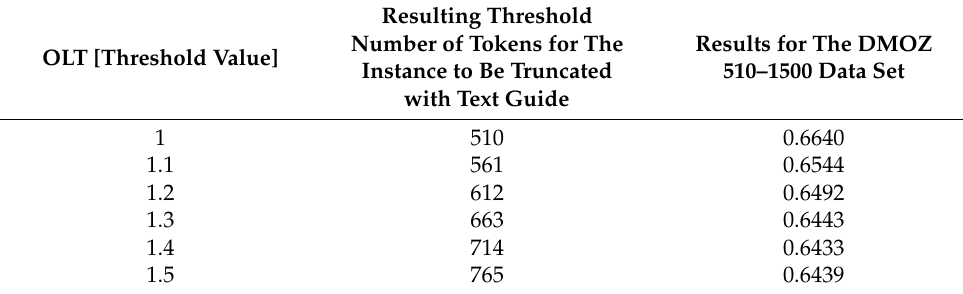
Table 5. Experiments on the DMOZ 510–1500 data set regarding the over length threshold (OLT), i.e., the threshold length of the text instance from which Text Guide is to be used. For shorter text instances, a naive truncation method was used. Experiments were performed with Text Guide by using all occurrences of important token features found in the original text